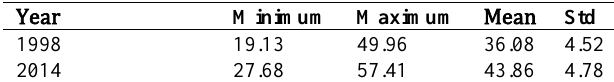
Table 2. Descriptive statistical parameters derived from resultant